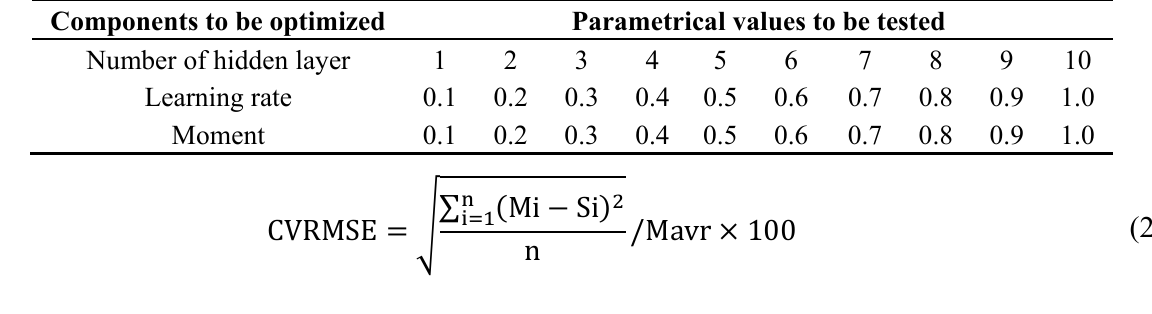
Table 5. Parametrically tested values for optimizing the ANN components. Components to be